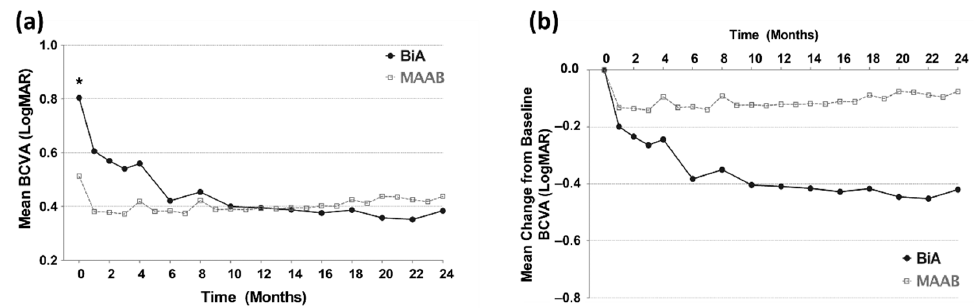
Figure 2. Visual outcome from baseline to the 24th month. ( a ) Compared to the BiA group, the MAAB group has better BCVA at baseline. * p = 0.001 by two-tailed unpaired t -test. ( b ) The BiA group shows greater improvement in BCVA than does the MAAB group.